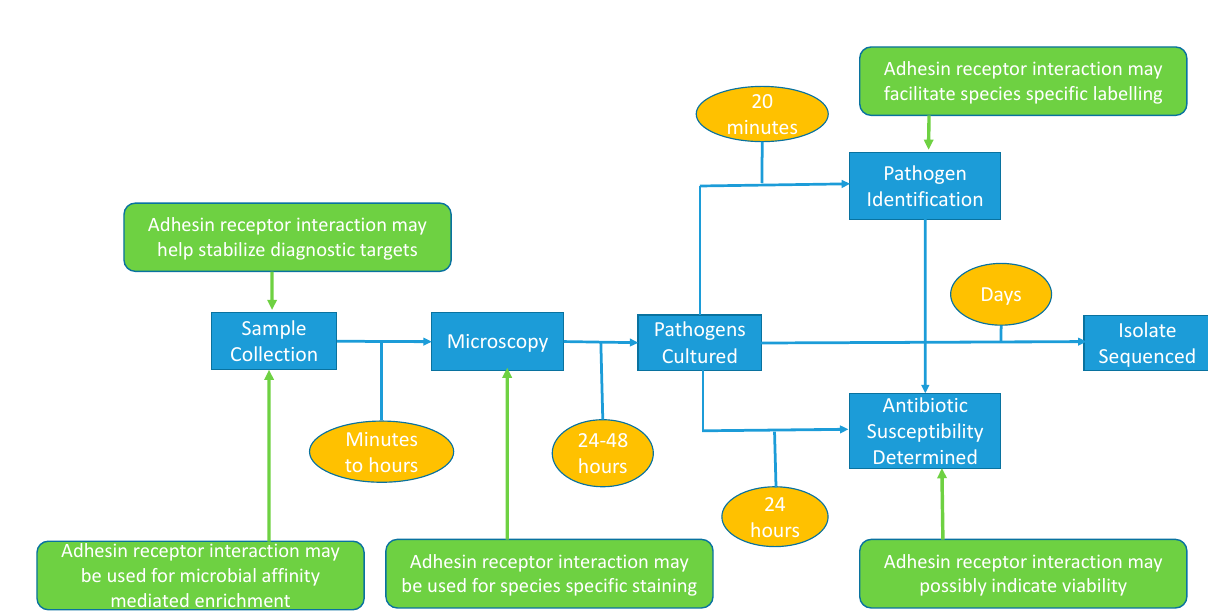
Figure 3. Diagnostic workflow and technologies (blue boxes) used for the routine detection of pathogens. Current timing is indicated in orange boxes whereas the possible impact of adhesion-based assays is indicated in green.